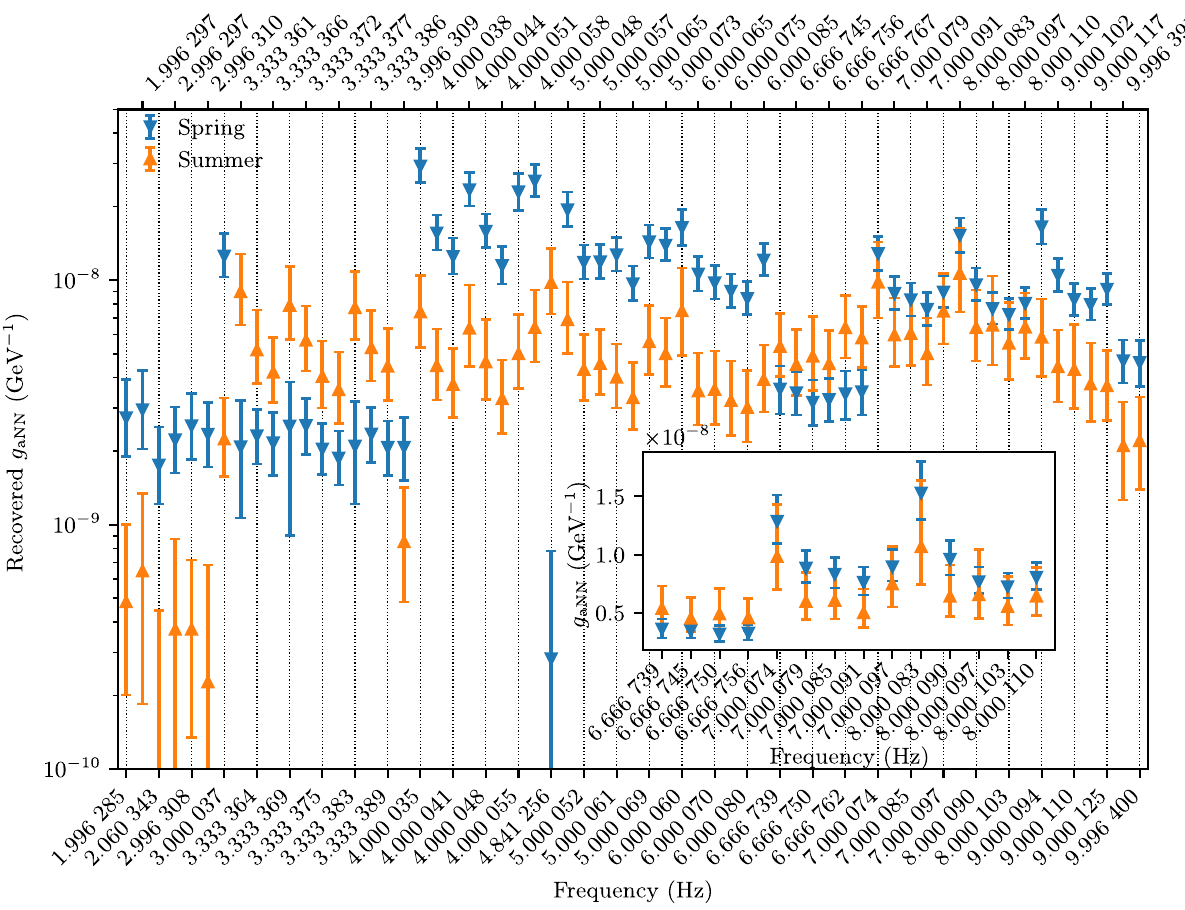
FIG. 8. Best-fit g recovered from both the spring and summer datasets for all axion masses with q 0 > 52 . 1 corresponding to a aNN significance of more than 5 σ after taking into account the look-elsewhere effect. Error bars show the 95% confidence intervals for the best-fit values. Of the 63 possible candidates shown here, only 14 have overlapping confidence intervals. These candidates are also shown in the